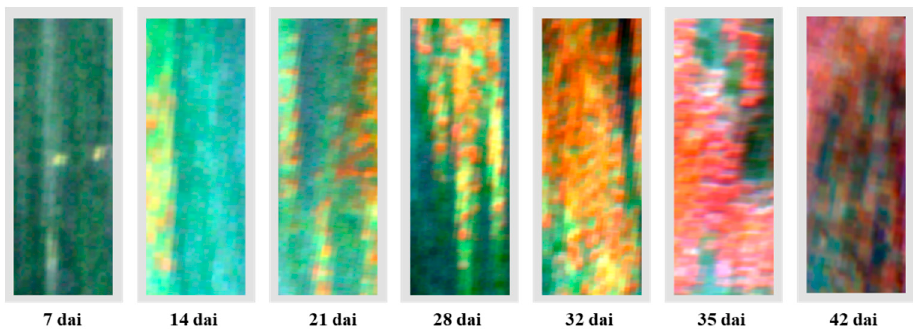
Figure 3. Development of disease symptoms of wheat yellow rust from 7 dai to 42 dai.